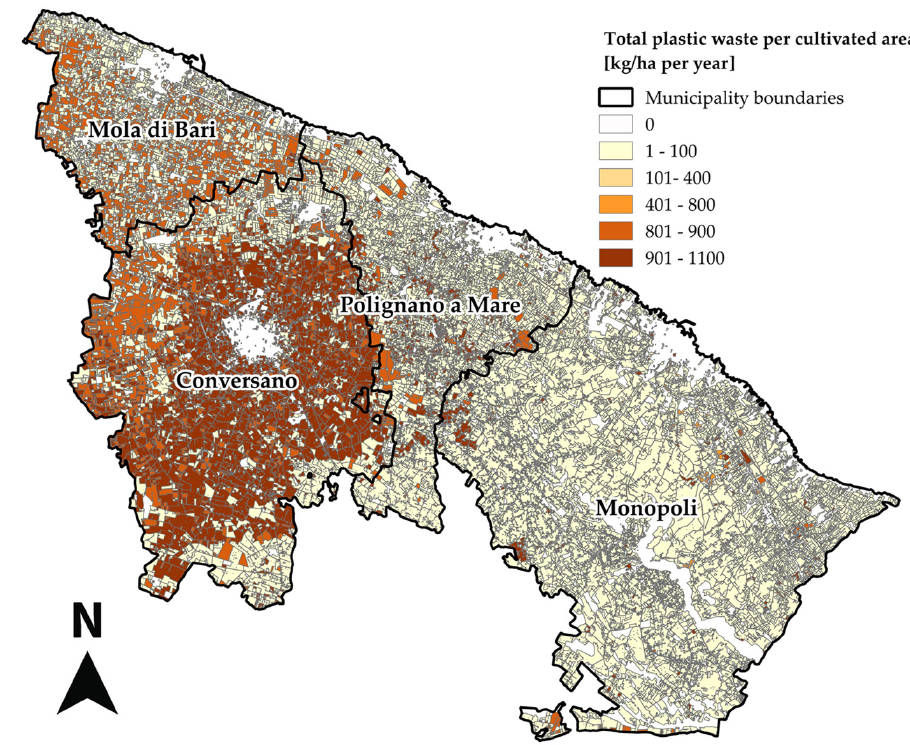
Figure 2. Distribution of the total APW in the four municipalities in the actual scenario.